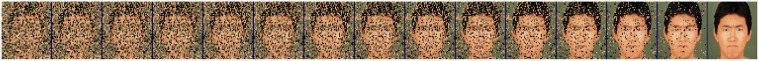
Example test sequence.Anger (no covering) is pictured. The image is from a set of photographs entitled Japanese and Caucasian Facial Expressions of Emotion (JACFEE) by D. Matsumoto and P. Ekman, University of California, San Francisco, 1988. Copyright 1988 by D. Matsumoto and P. Ekman. Reprinted by permission.